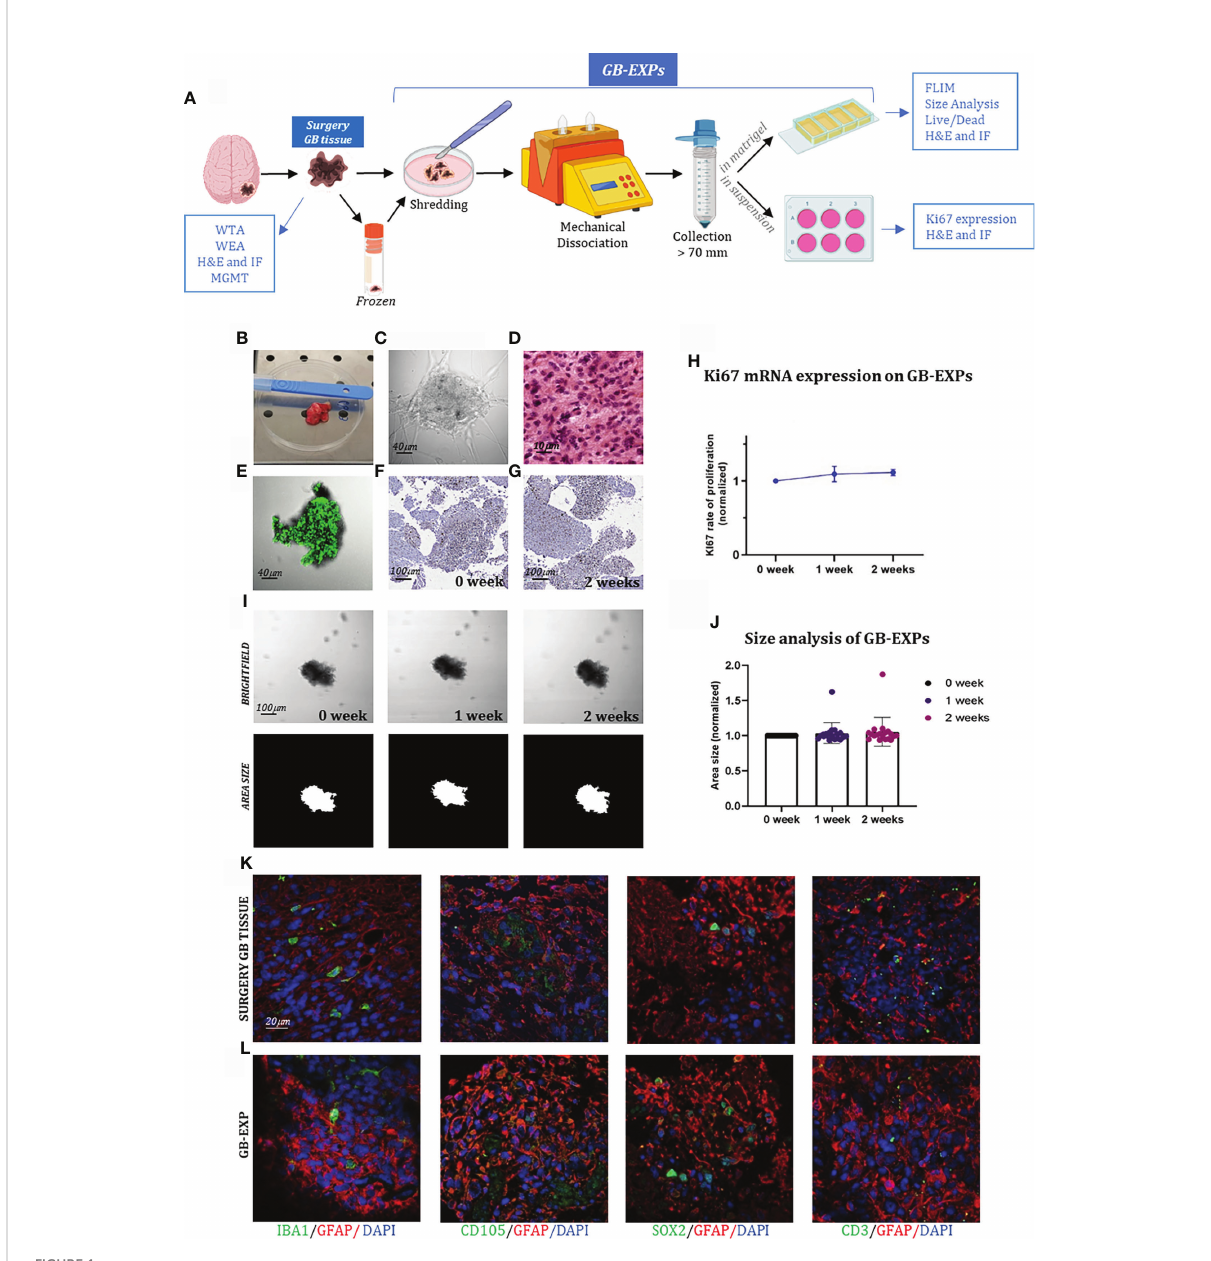
FIGURE 1 GB-EXPs cultures (A) Experimental design. (B) A surgery tumor sample. (C) GB-EXP embedded in matrigel. (D) H&E staining of a surgery GB tissue. (E) Live/dead staining of a GB-EXP at 2 weeks after culturing. (F, G) Ki67 immunostaining of GB-EXPs in suspension at 0 week and 2 weeks. (H) Ki67 mRNA expression analysis of 13 GB case-derived GB-EXPs at 0 and 2 weeks. Graph represents mean ± s.d. of triplicated measures. (I) Representative bright fi eld and area size images of a GB-EXP in matrigel at 0 week, 1 week and 2 weeks. (J) Size analysis 20 GB case-derived GB-EXPs at 0, 1 and 2 weeks. (K, L) Immuno fl uorescence assays of surgery GB tissue (K) and GB-EXPs (L) . GFAP (astrocytes), IBA1 (microglia), SOX2 (stem cells), CD105 (endothelial cells) and CD3 (lymphocytes). WTA, Whole Transcriptome Analysis; WEA, Whole Exome Analysis; FC, Flow Cytometry; H&E, Hematoxylin, and Eosin; MGMT, MGMT promoter methylation